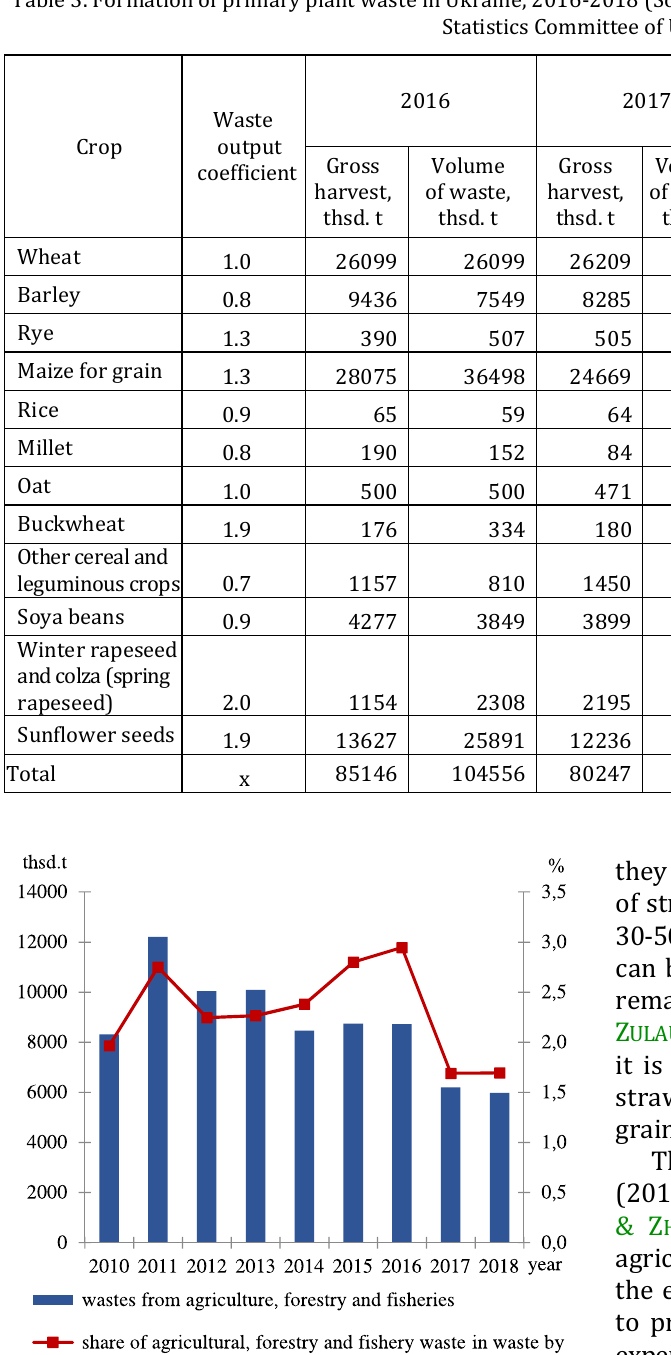
Table 3. Formation of primary plant waste in Ukraine, 2016-2018 (Source: calculated by the authors according to the State